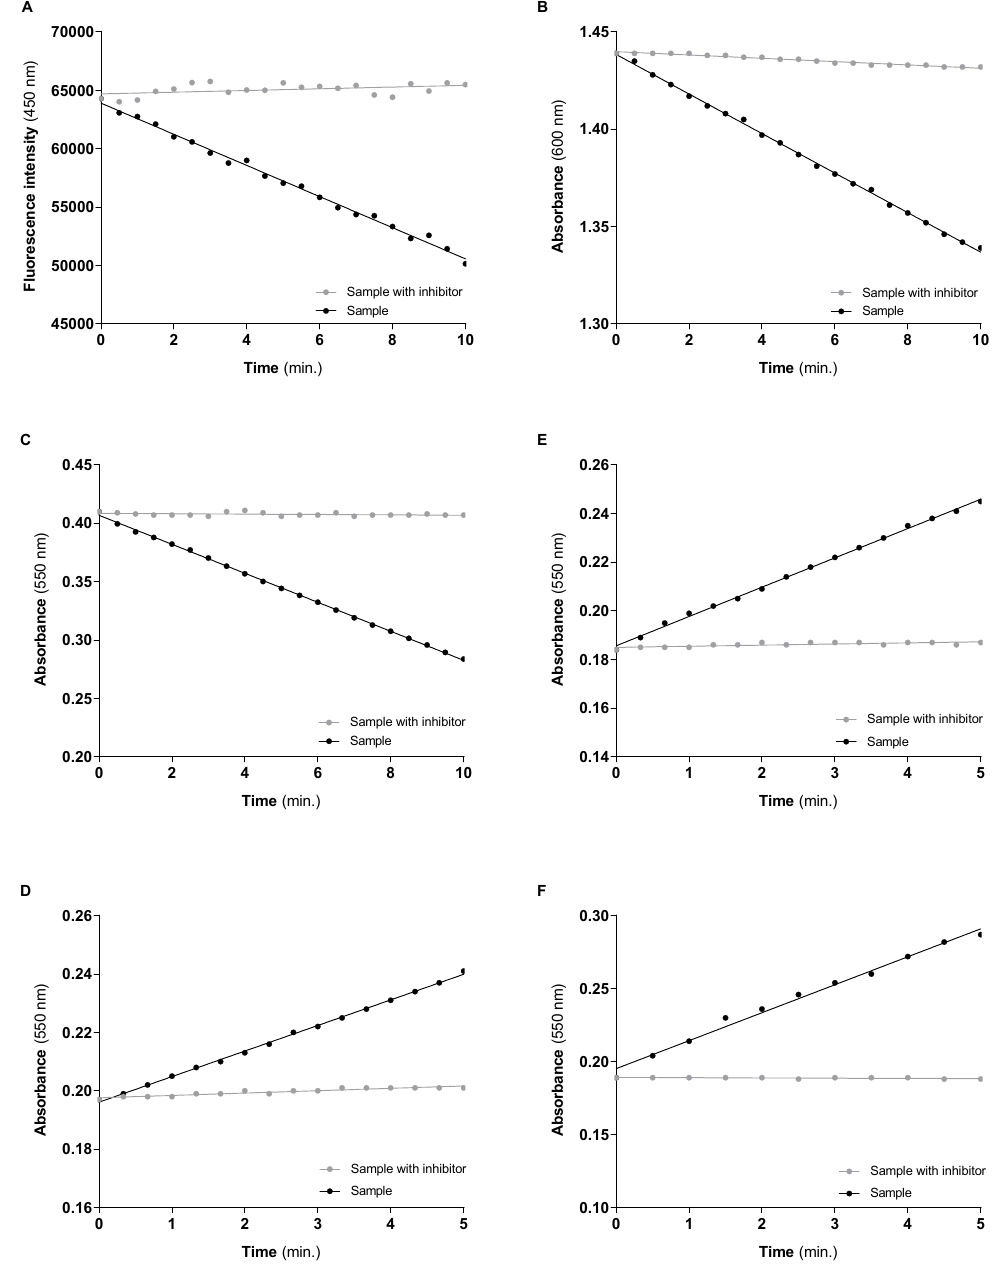
Figure 14. Typical progress curves were used to assess the activities of Complex I ( A ), II ( B ), IV ( C ), I–III ( D ), II–III ( E ) and CS ( F ) in the mitochondria-rich fraction. The mitochondrial respiratory chain complexes activities and the CS activity are calculated by the difference between the slopes on the presence (grey lines) and absence (black lines) of the inhibitors used for each activity.